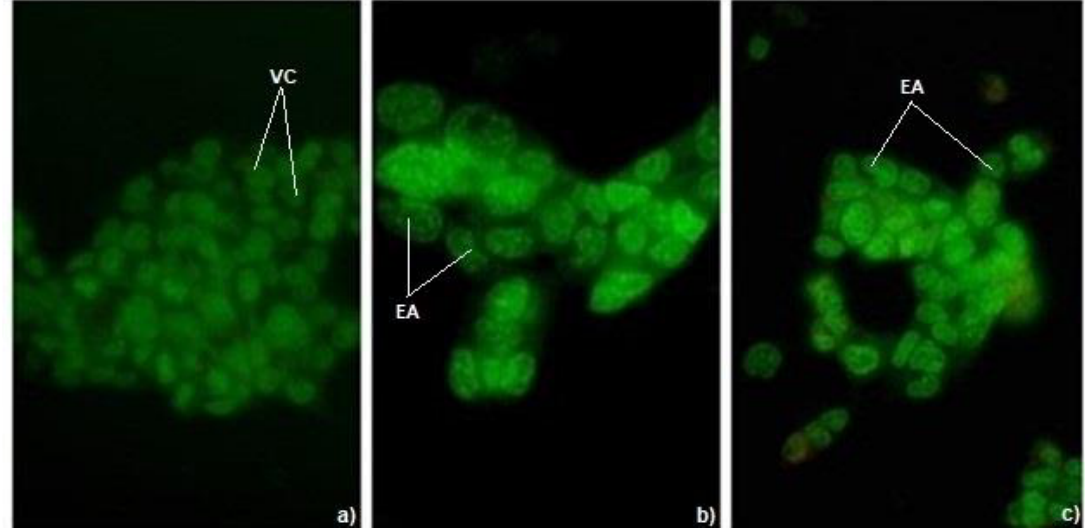
Figure 2. Typical morphological changes in HCT-116 colorectal carcinoma cells stained with AO/EB after treatment with O. minimum (a-control, b-10 µg/mL, c-100 µg/mL). Mediation of redox homeostasis by Ocimum minimum